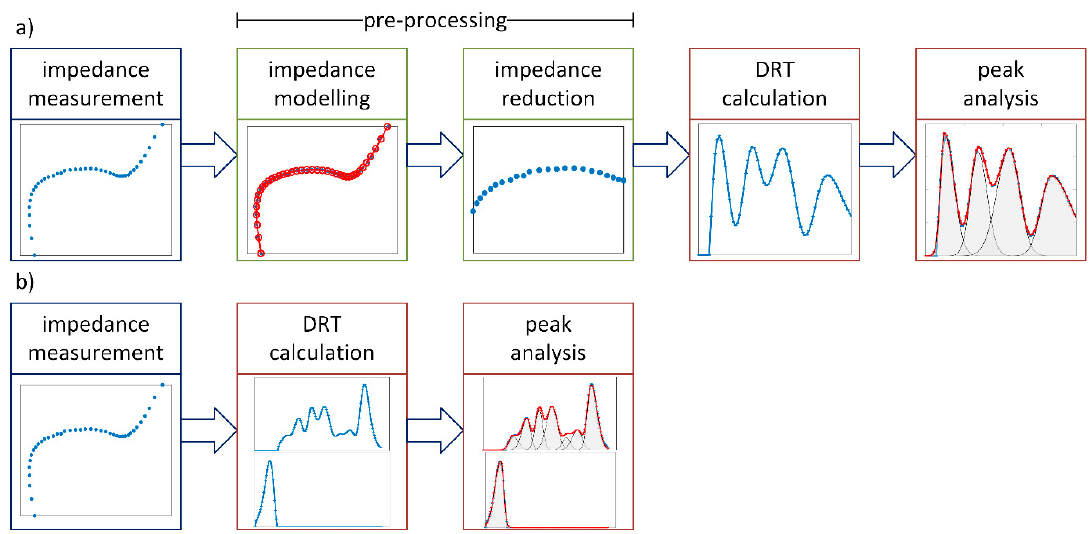
Figure 3. ( a ) Work flow of state of the art DRT analysis with two model-based steps for preprocessing measured impedance data to extract the resistive-capacitive behavior of the measured spectrum; ( b ) Reduced work flow of model-free generalized DRT analysis without the need of data preprocessing resulting in two distribution functions of relaxation times, one for the resistive-capacitive behavior and one for the resistive-inductive behavior.